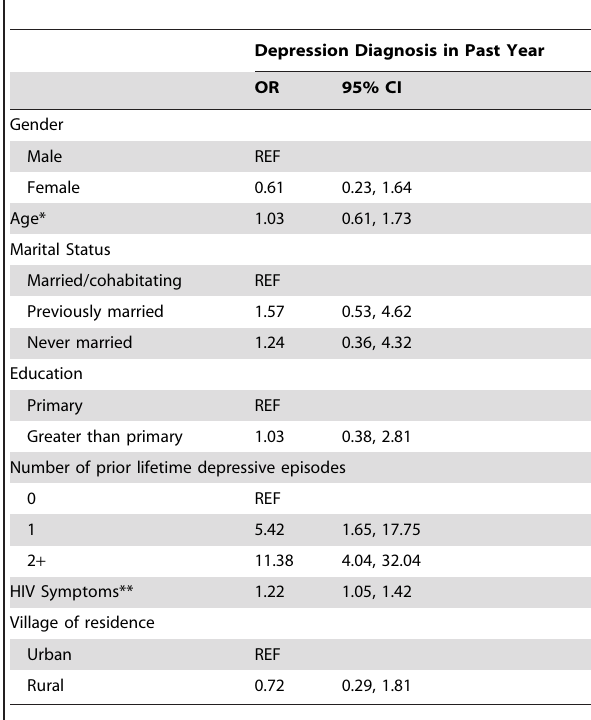
Table 6. Correlates of depression diagnosis – multivariable